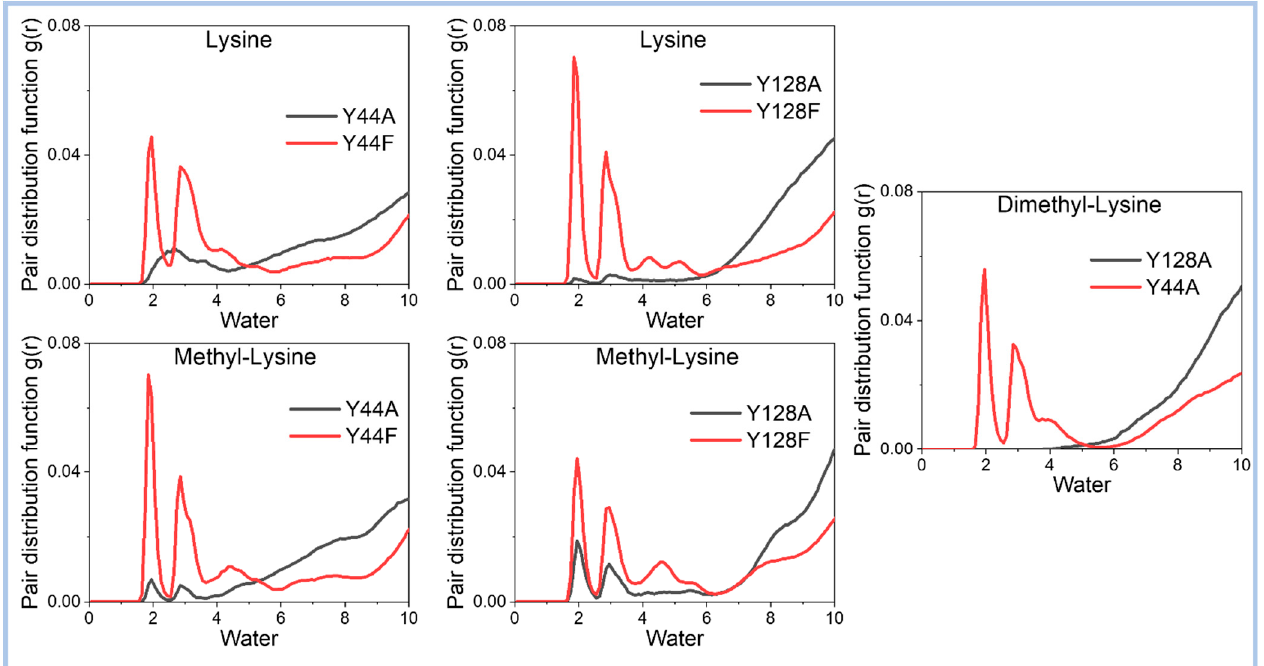
Figure 8. Plots of the pair-distribution functions for the interaction between the nitrogen from the lysine substrate (N ε (K4)) and any water within a radius of 10 Å sampled along 50 ns of molecular dynamic simulations for the unmethylated, mono-methylated, and di-methylated lysine, for all the mutant states here studied.